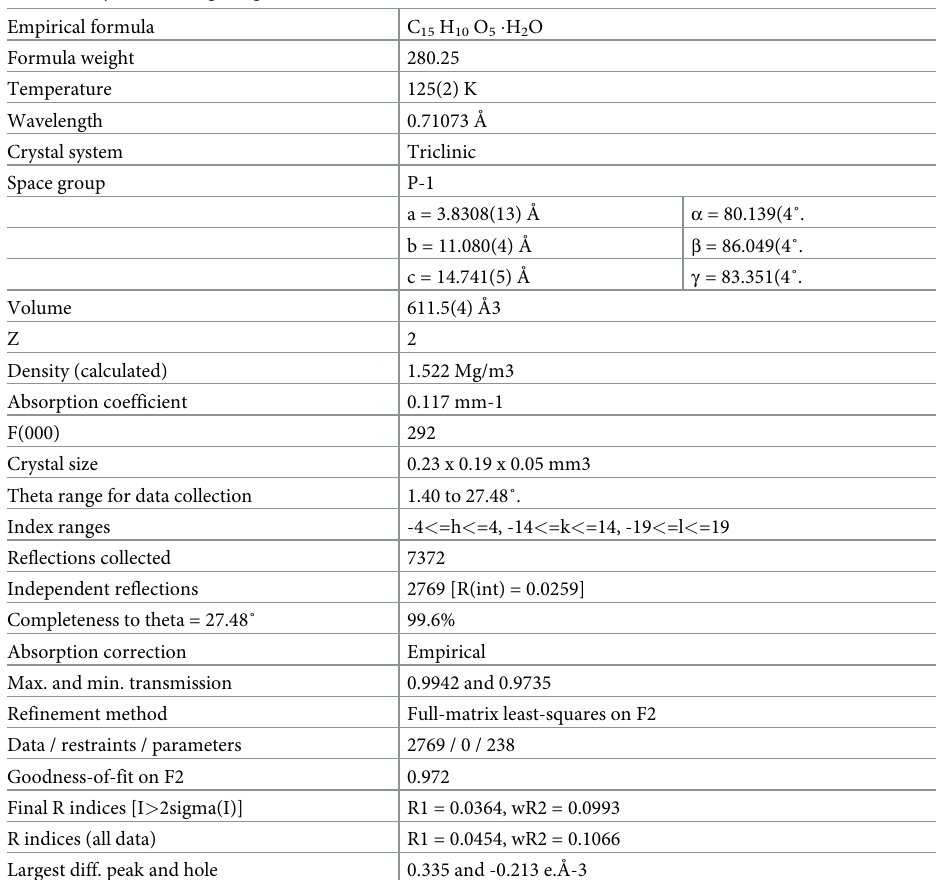
Table 1. Crystal data of galangin ● H 2